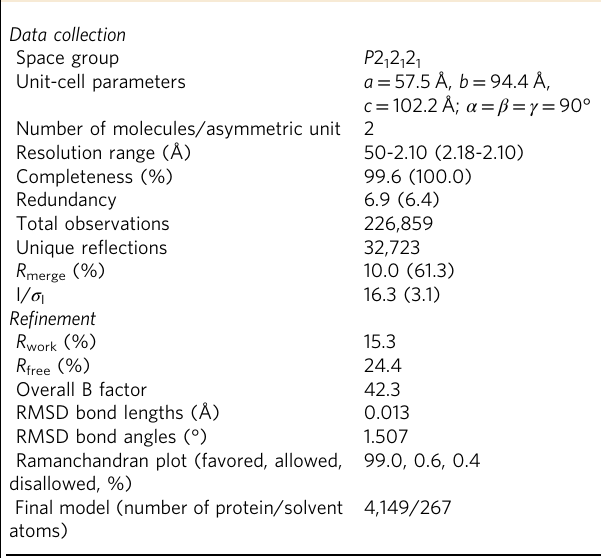
Table 1 Data collection and re fi nement